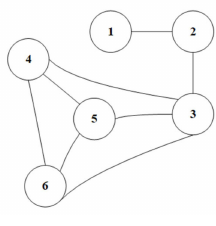
Figure 9. Random undirected